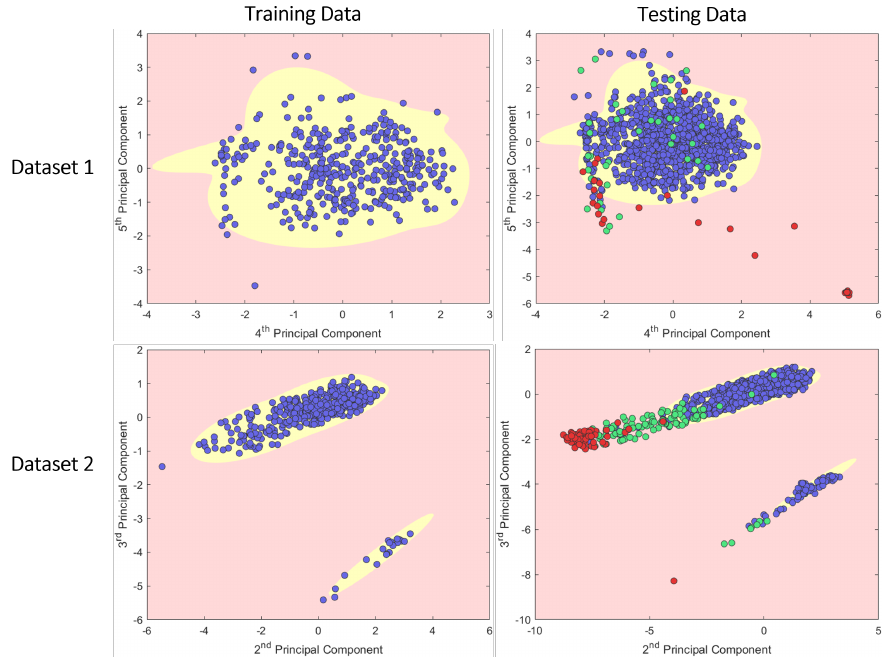
Figure 7. Outlier regions calculated using Gaussian mixture model trained on the reduced normal data. Any points that fall in the red area are identified as anomalies. Labelled data includes Nominal points (blue), ANC (green), and True Anomalies